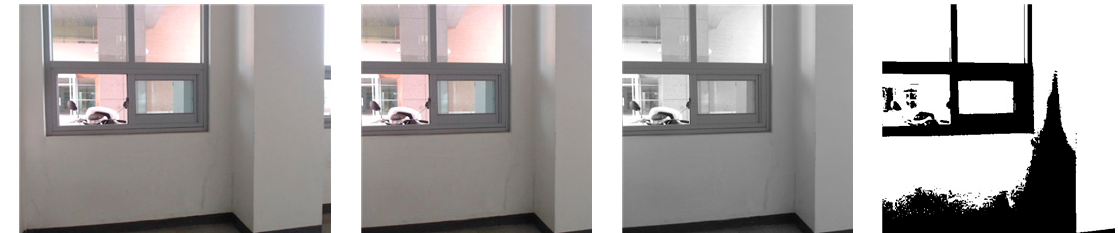
Figure 9. Convert process of original image. ( a ) Original image; ( b ) crop image; ( c ) gray-scale image; ( d ) binary image.